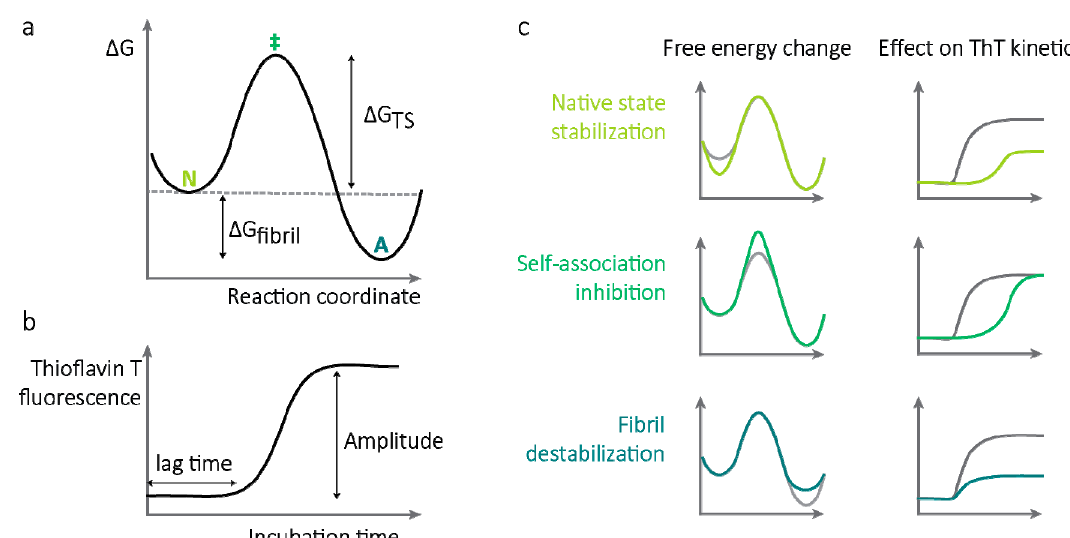
Figure 2. Mechanisms by which small molecules could inhibit amyloidogenesis. ( a ) Simple model of aggregation, where native (N) and amyloid (A) states are separated by a single transition state (‡), which represents the complex process of self-association of amyloid-competent LCs. Two free energy differences define the behavior of this system: Δ G fibril is the free energy difference between the native and fibril states, which defines the equilibrium concentrations of these two states, and Δ G TS is the free energy barrier to aggregation (or disaggregation), which defines the rate at which the system reaches equilibrium. Note that this model conflates initiation and extension of amyloid fibrils. Δ G fibril defines the critical concentration, or solubility limit, of a protein. ( b ) Expected results from an aggregation kinetics measurement using thioflavin T (ThT) fluorescence. The steep rise in fluorescence is due to the increased rate of fibril formation in the presence of existing fibrils. If the simple model depicted in panel ( a ) is correct, the ThT fluorescence amplitude reports on Δ G fibril and the lag time reports on Δ G TS . ( c ) The effect of small molecules on aggregation kinetics can indicate the mechanisms by which the molecules affect the aggregation reaction. Green lines show the predicted effects of each mechanism. Stabilizing the native state (top) should increase the lag time and decrease the fluorescence amplitude. Destabilizing the transition state (middle) should increase the lag time but not affect the endpoint fluorescence. Destabilizing the fibrils (bottom) should decrease the endpoint fluorescence amplitude but not affect the lag time.